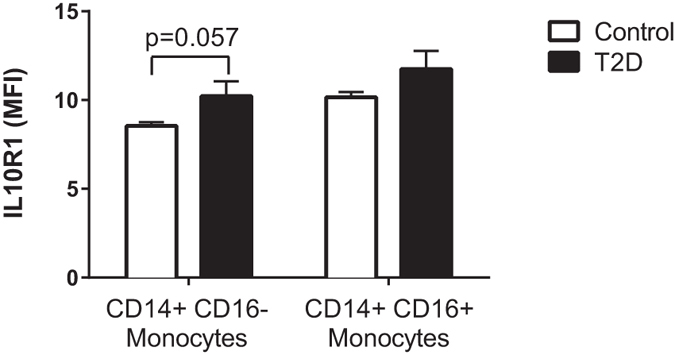
No significant difference in IL10R1 expression on monocytes in T2D.IL10R1 was measured on CD14+/CD16− and CD16+ monocytes by flow cytometry in the T2D and age and BMI-matched non-T2D control participants. Unpaired t-tests indicated that IL10R1 expression was not significantly different on either monocyte subset although IL10R1 tended to be lower on CD14+/CD16− classical monocytes in T2D (P = 0.057). Values are mean ± SEM.